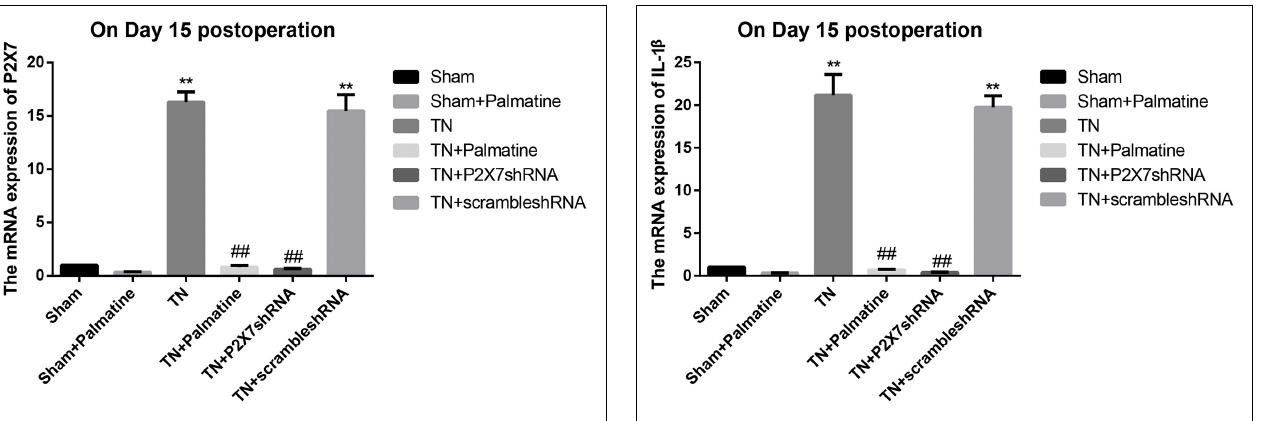
FIGURE 2 | P2X7 mRNA expression in TGs of each group detected by qRT-PCR on 15 days after operation. Values are mean ± SD, n = 6, ** p < 0.01 vs. sham group, ## p < 0.01 vs. TN group.